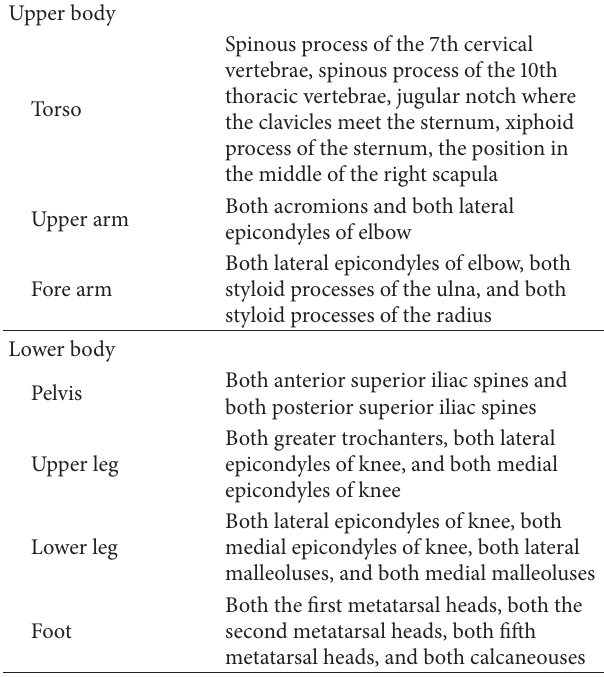
Figure 3: Measurement conditions: we compared four conditions with the use of two pressure sensors at the heel and fifth metatarsal (right): (i) without auditory feedback but with prosthesis, called “without” condition; (ii) auditory feedback from only the heel sensor, called “heel” condition; (iii) auditory feedback from only the fifth metatarsal sensor, called “fifth” condition; and (iv) auditory feedback from both the heel and fifth metatarsal sensors, called “all” condition. These four conditions were conducted in a random order. Table 2: Segment and placement of markers on the body.